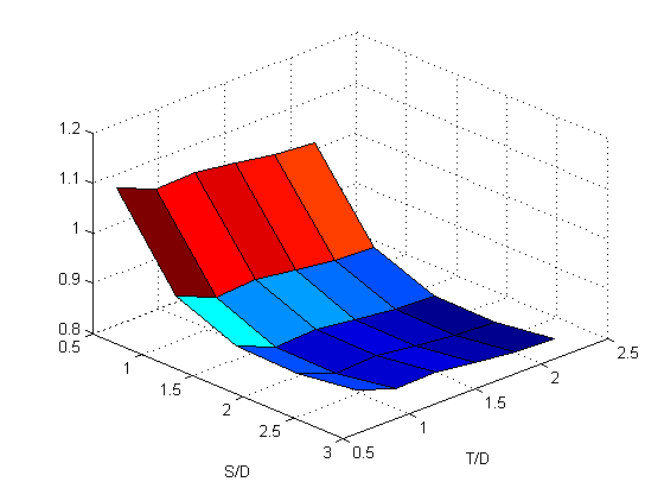
Figure 6. Real data plot of the drag coefficient.